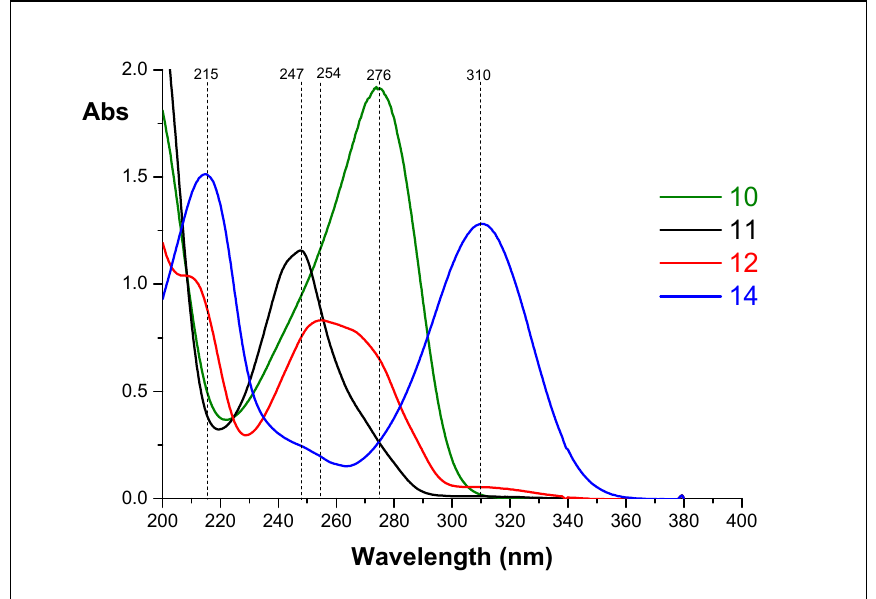
Figure 6. The UV spectra of compounds 10 , 11 , 12 , and 14 (D 2 O, appeared pH 4.1). The set of UV spectra for hydrolysis of 11 is shown in Figure 7. The picture is somewhat complicated due to the overlay of spectra of individual components. However, it can be seen that, in 48 h (magenta line), some quantity of 12 (shoulder at 270 nm) and 14 ( λ max 310 nm) is formed.